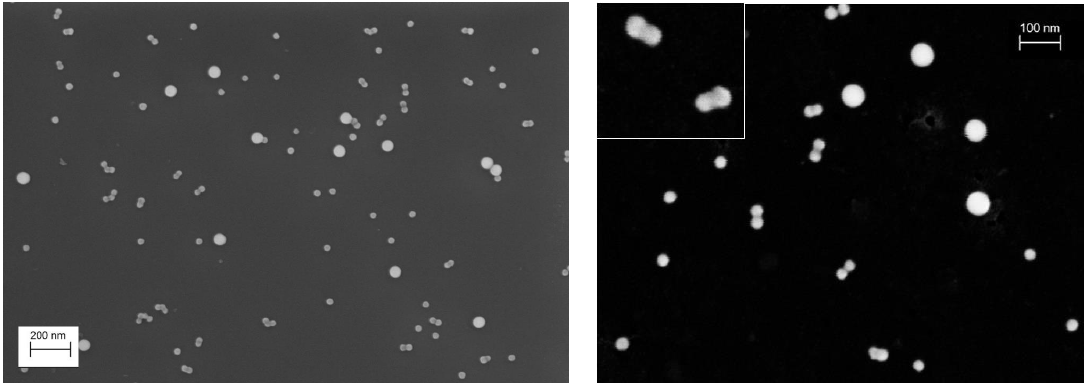
Figure 3. Representative SEM images of nPSize12 NPs (bimodal SiO 2